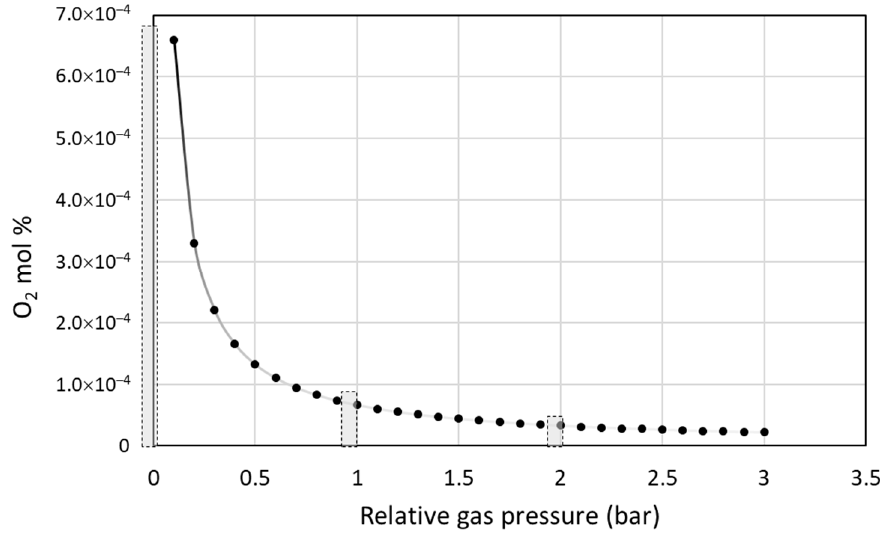
Figure 11. Content of residual oxygen in the processing chamber corresponding with the relative gas pressure established with Ar gas over the residue pressure of 0.3 mbar. The bars indicate conditions explored in this study.